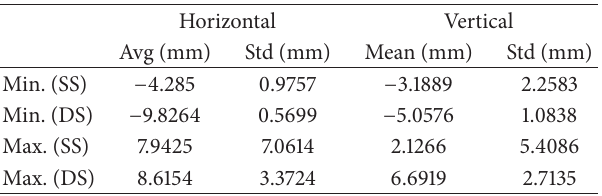
Table 1: Average (avg) and standard deviation (std) values of minima and maxima of the HJC differences for both single support (SS) and double support (DS)